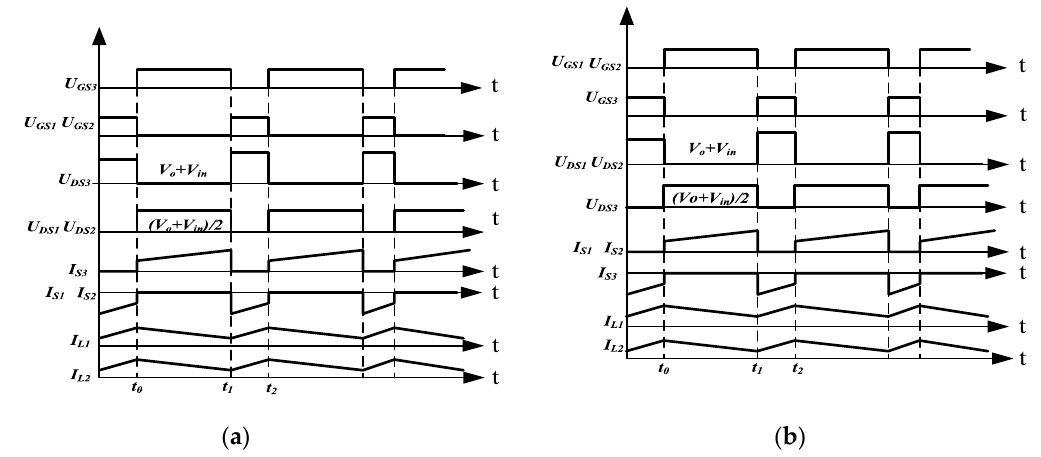
Figure 9. Typical waveforms of Converter III: ( a ) Boost mode and ( b ) Buck mode.